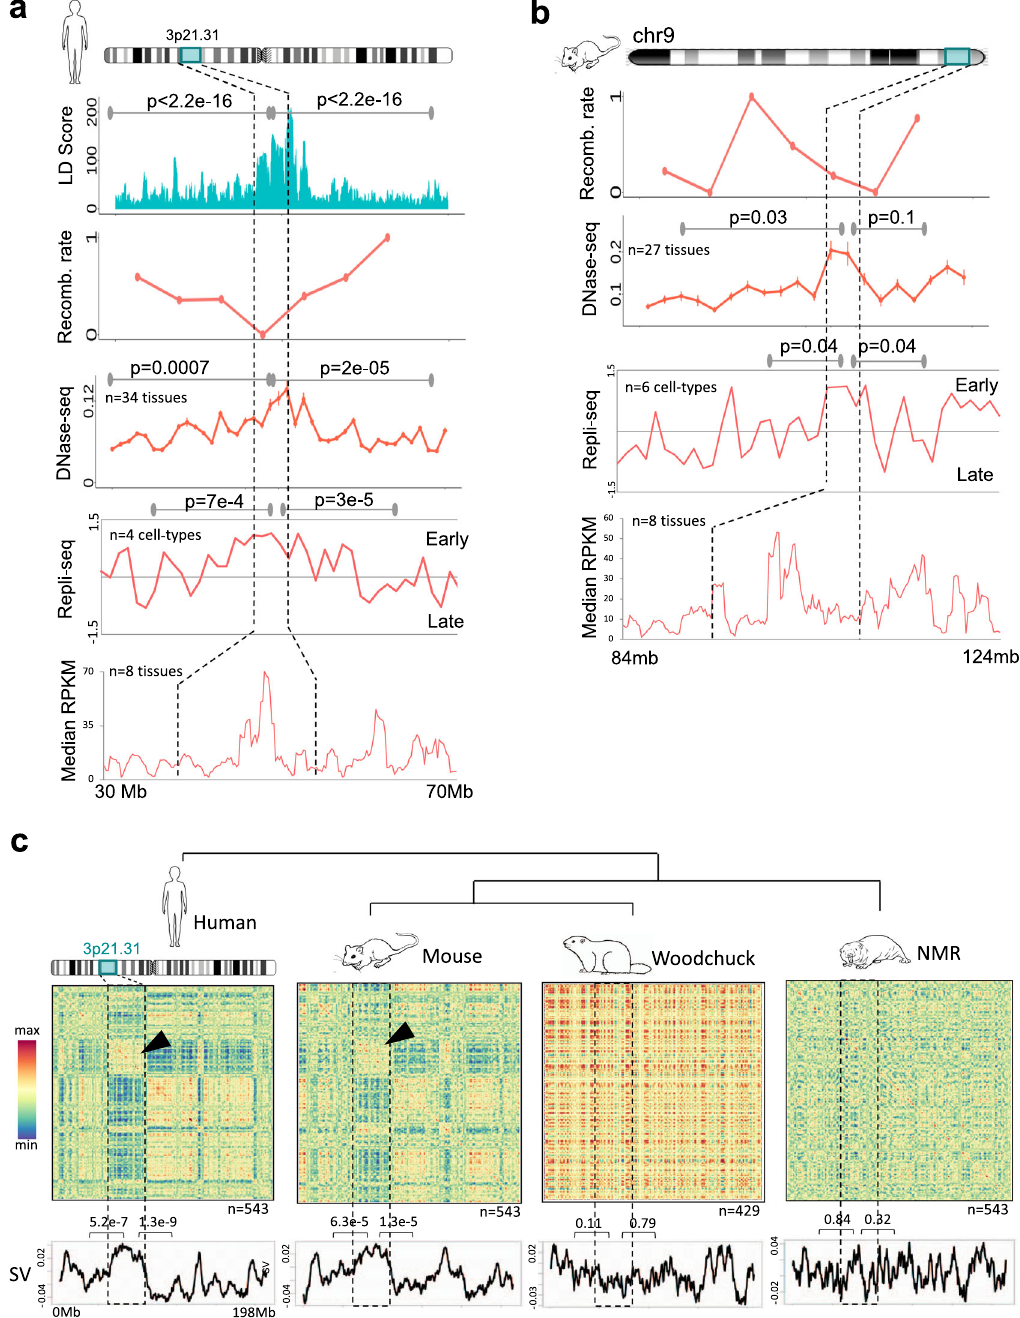
Fig. 4 Genetic and epigenetic attributes of 3p21.31 in human and mouse. a , b Linkage disequilibrium (LD) score, recombination rate, chromatin accessibility (across 34 human and 27 mouse tissues), replication timing (across four human and six mouse cell types) and the median expression levels of genes (across eight tissues) in human ( a ) and in mouse ( b ). P values for the comparison of values in the 3p21.31 locus and in the adjacent regions were calculated using two-sided Mann – Whitney U tests. Error bars represent 95% con fi dence intervals. Effect sizes: 0.25 and 0.29 for LD score; 0.63 and 0.41 for DNase-seq (human); 0.66 and 0.16 for DNase-seq (mouse); 0.99 and 1.28 for Repli-seq (human); 0.66 and 1.2 for Repli-seq (mouse). c Co-expression heatmaps of genes from human chromosome 3, and the corresponding orthologues in mouse, woodchuck and naked-mole rat. Below each heatmap is the leading singular vector (SV) of co-expression matrix. High overall SV values at 3p21.31 in human and mouse signify its secluded transcriptional co-regulation, which was largely independent from rest of the chr3. P values were calculated using two-tailed unpaired t -test using the same approach as in Fig. 3b. Effect sizes: 0.82, 1.01 (human); 0.64, 0.71 (mouse); 0.26, 0.04 (woodchuck); 0.02, 0.15